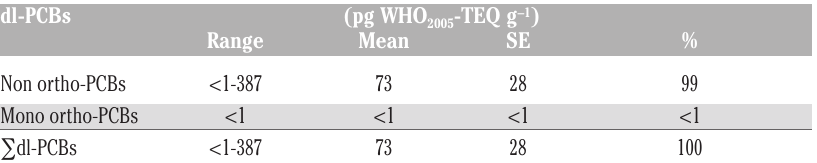
Table 3. Toxic equivalent quotients of dioxin-like polychlorinated biphenyl congeners in urban soils from Delhi, India. dl-PCBs (pg WHO -TEQ g –1 ) 2005 Range